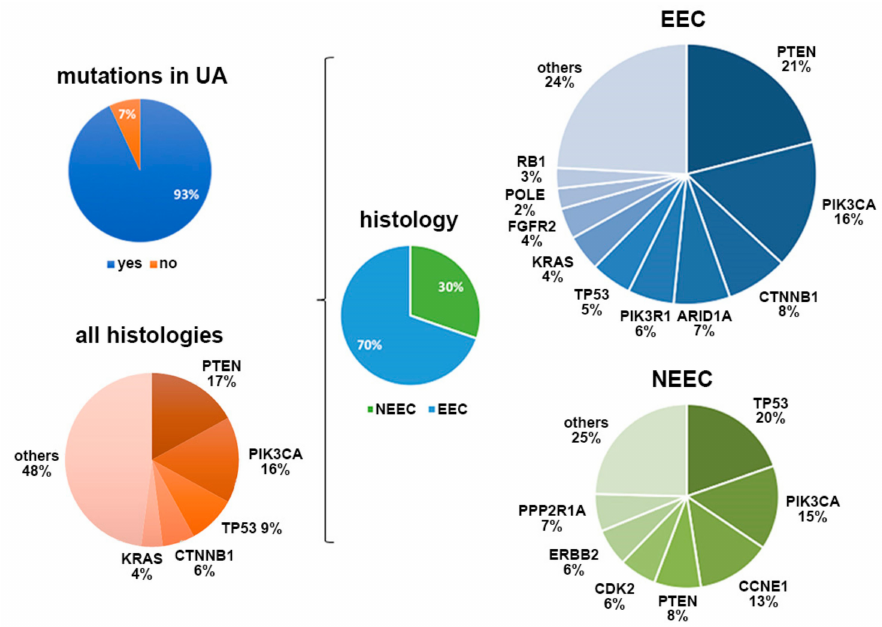
Figure 2. Summary of the most prevalent altered genes in UAs and their distribution according to tumor histology. UA, uterine aspirate; EEC, endometrioid carcinomas; NEEC, non-endometrioid